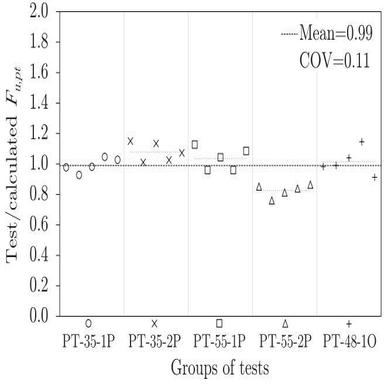
Comparison between experimental and calculated values of Fu,pt.